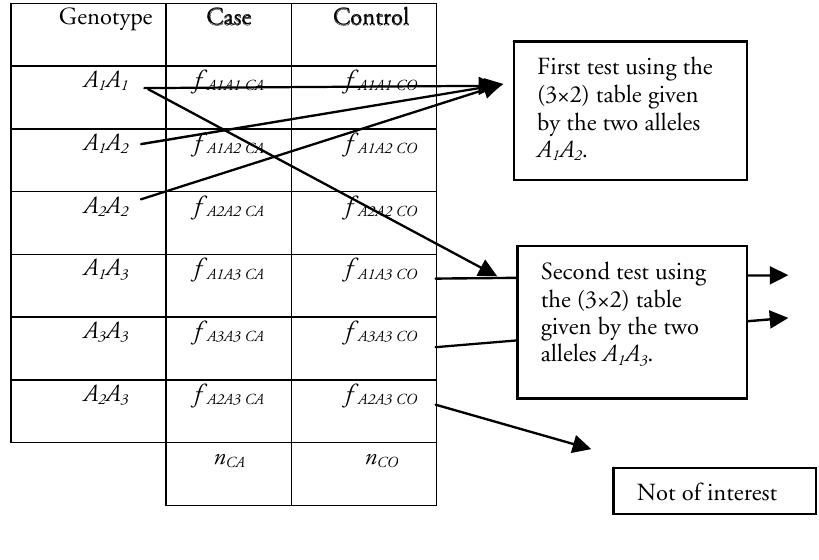
Figure 3 – Multiallelic problem.